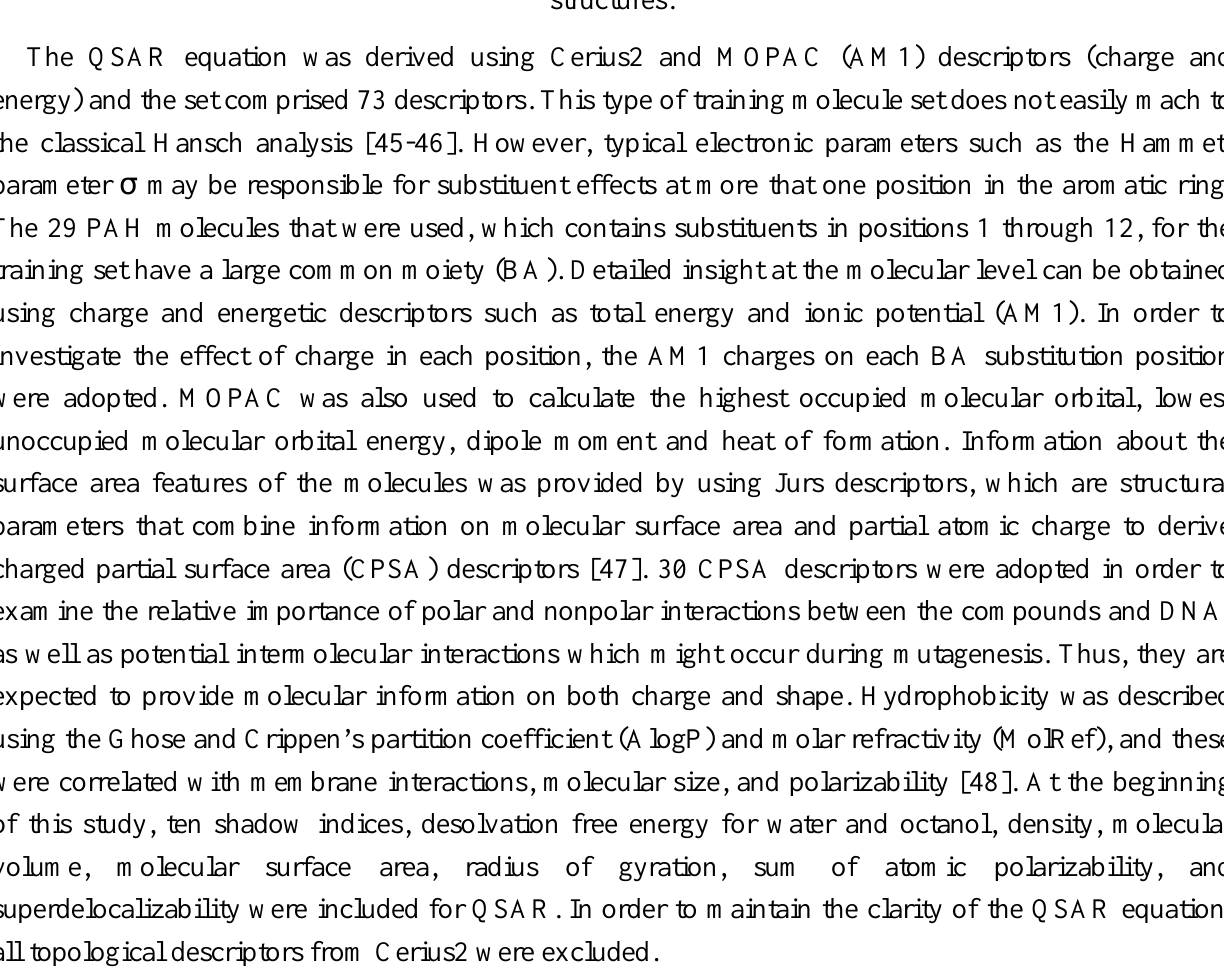
Figure 1. (A) The Benz[ a ]anthacene moiety in the xy-plane. (B) Superposition of the 29 BA